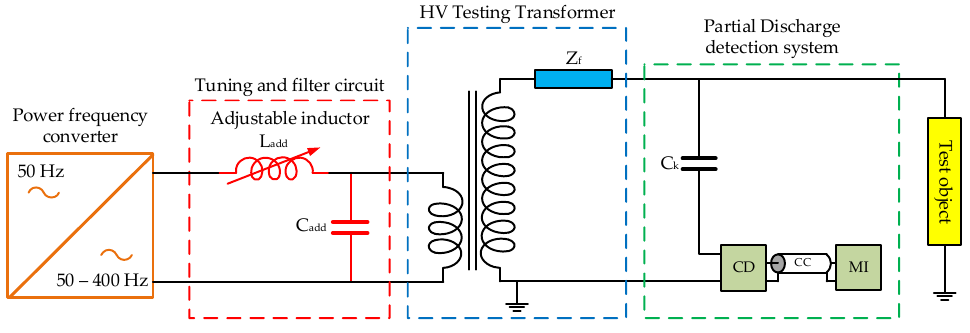
Figure 3. Partial discharge testing system.